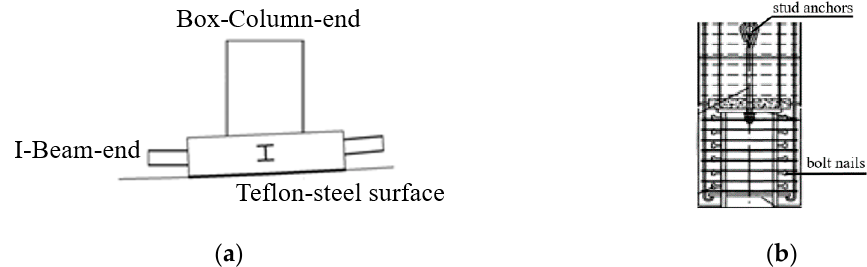
Figure 3. ( a ) Sliding block and ( b ) column end of super-large displacement friction pendulum bearing.